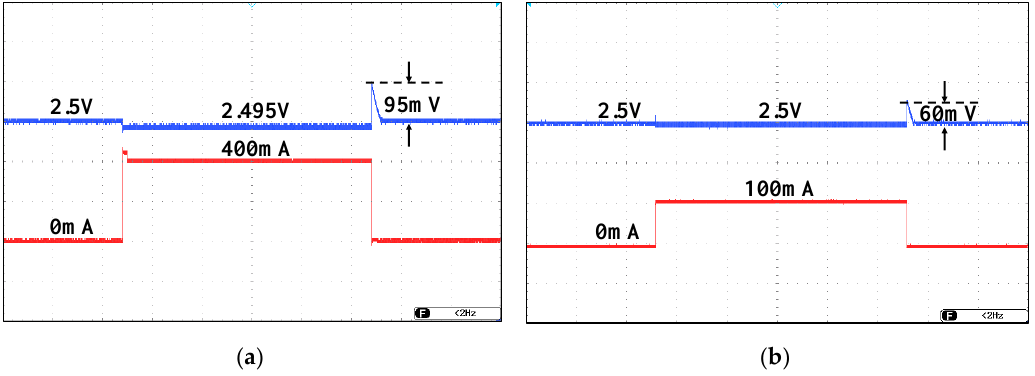
Figure 13. Measured transient load performance of the proposed linear regulator with supply voltage of 4 V. ( a ) Load current step is from 0 to 400 mA; ( b ) load current step is from 0 to 100 mA.